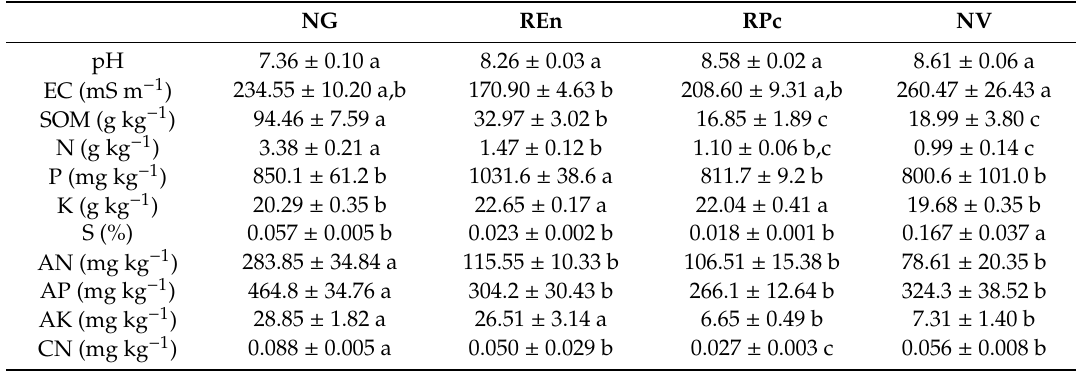
Table 1. Soil properties and CN content (mean ± standard error) in four